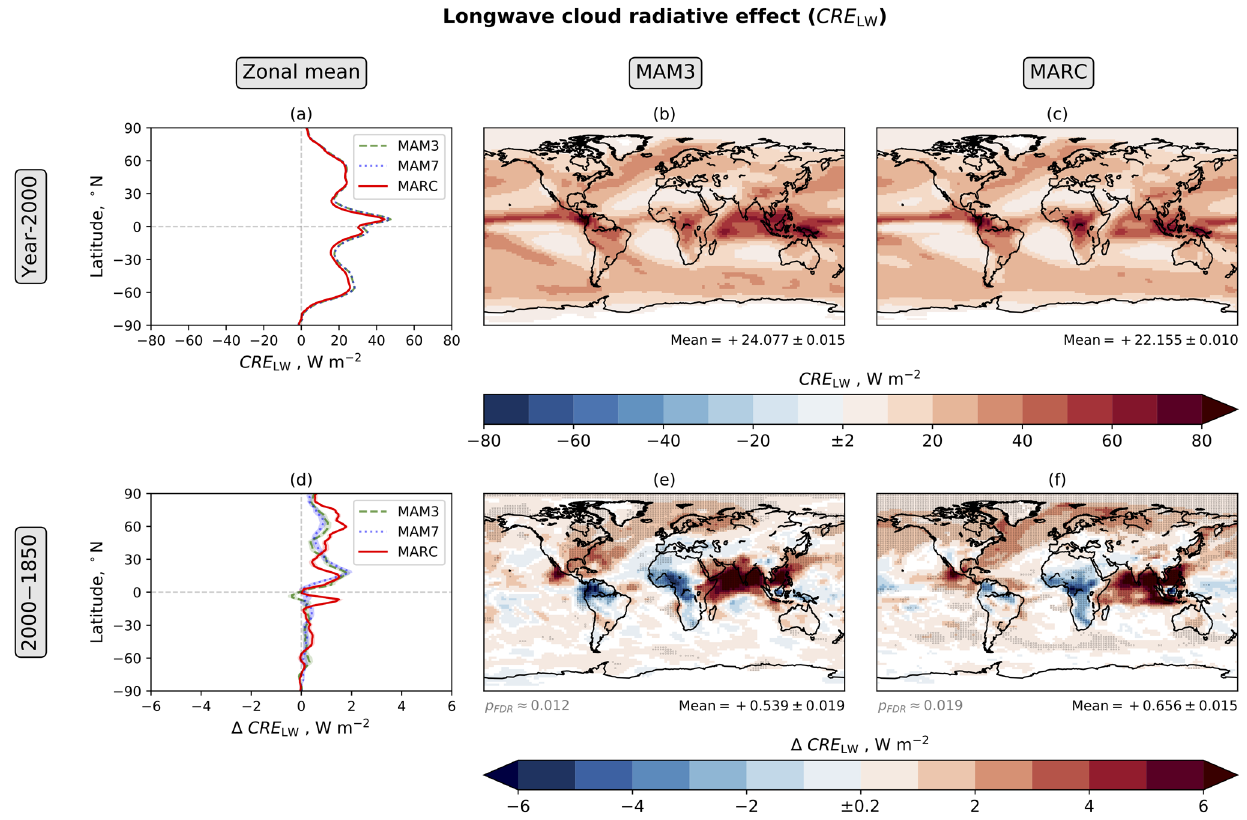
Figure 15. Annual mean longwave cloud radiative effect (CRE LW ; Eq. 6). The figure components are explained in the Fig. 2 caption. For all four maps, white indicates differences with a magnitude less than the threshold value in the centre of the corresponding colour bar.